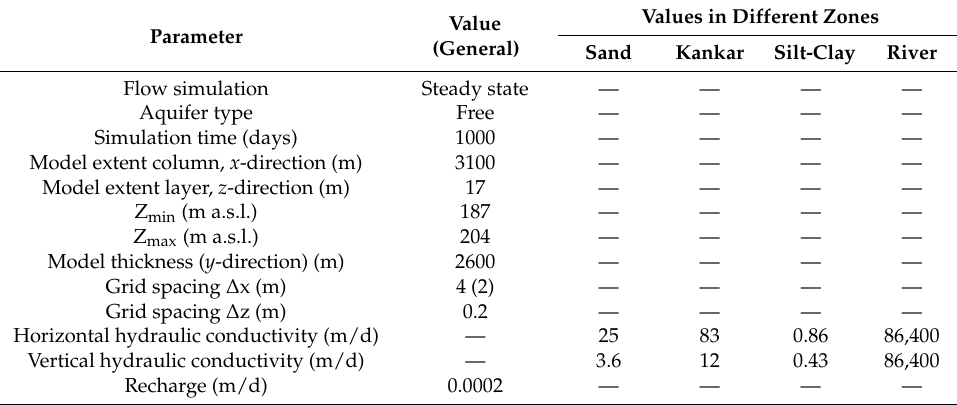
Table 1. Parameters used to set up the initial 2D flow models (models 1 and 2).